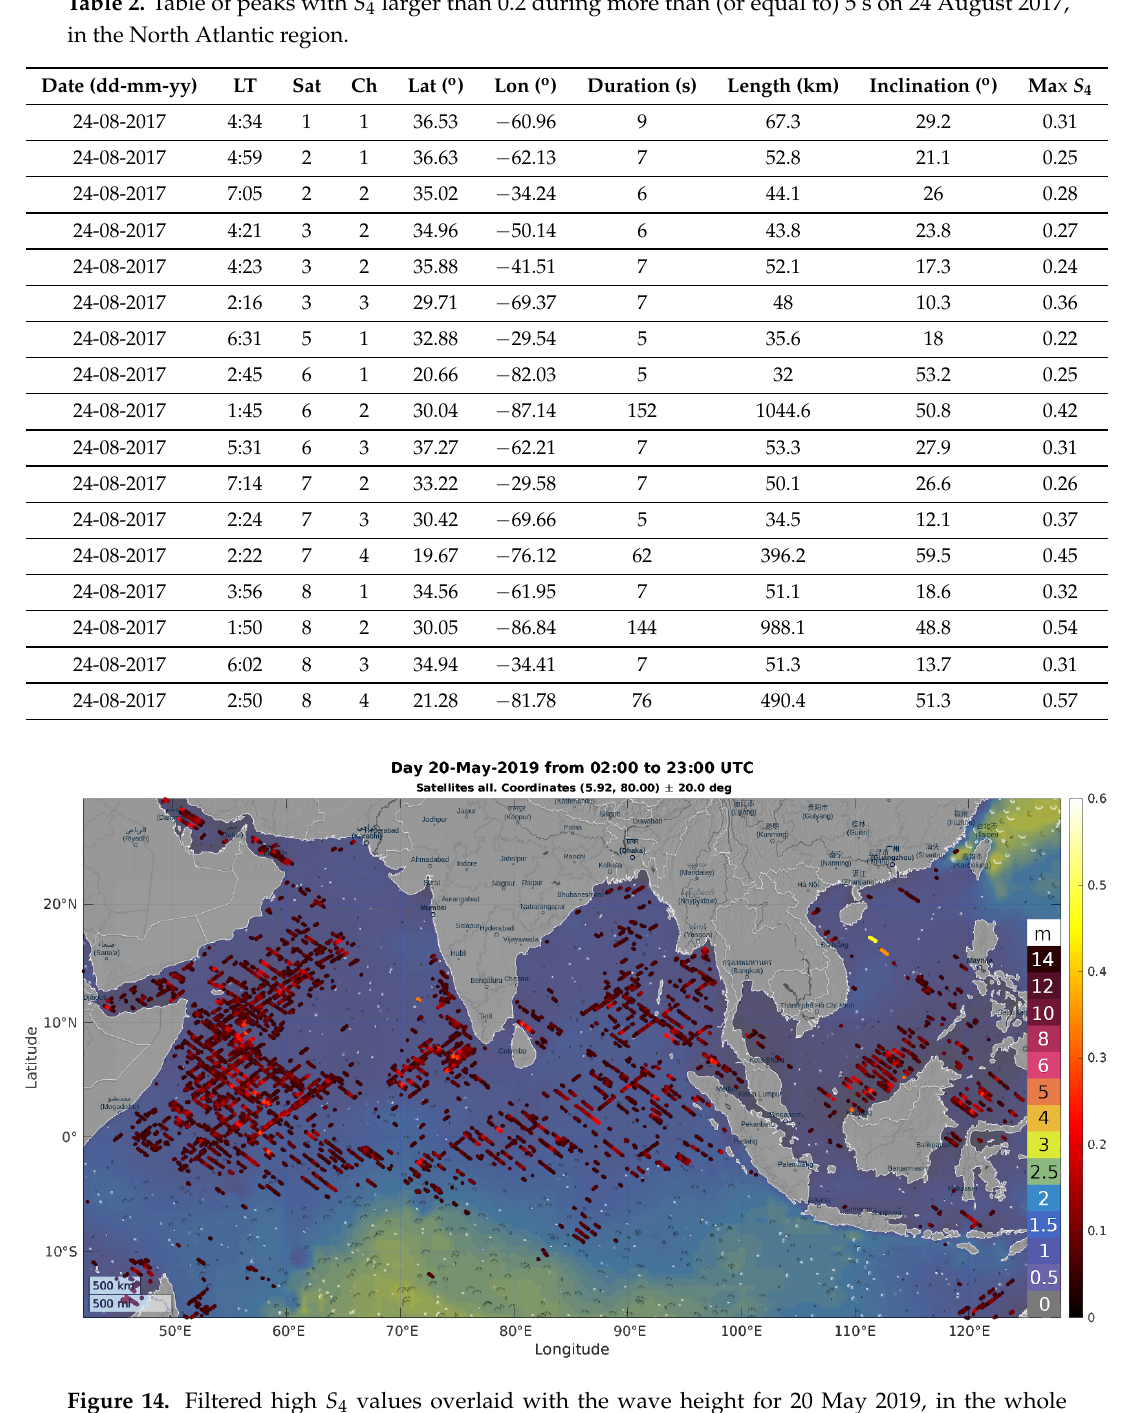
Figure 14. Filtered high S 4 values overlaid with the wave height for 20 May 2019, in the whole Indian